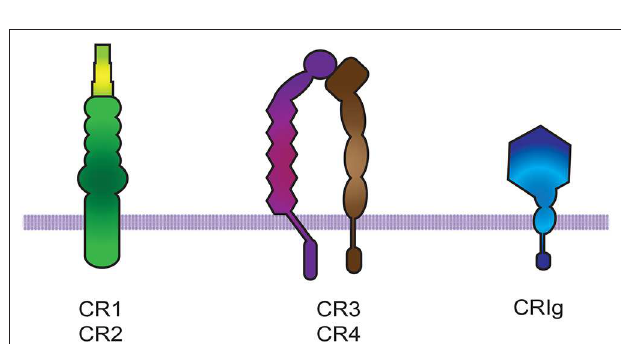
FIGURE 2 | Complement receptors. There are three groups of complement receptors: (i) the short consensus repeat (SCR) modules that code for CR1 and CR2, (ii) the β 2 integrin family members CR3 and CR4 (66), and (iii) the immunoglobulin Ig-superfamily member